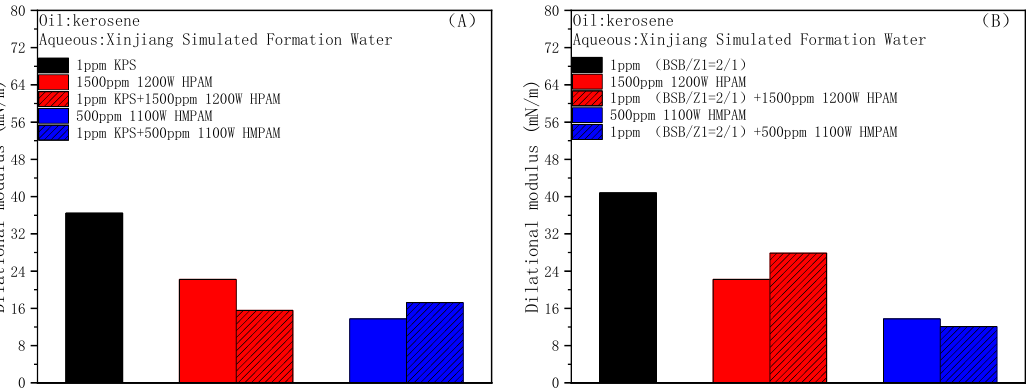
Figure 9. Effects of HPAM and HMPAM on the interfacial dilational modulus of KPS ( A ) and BSB ( B ).